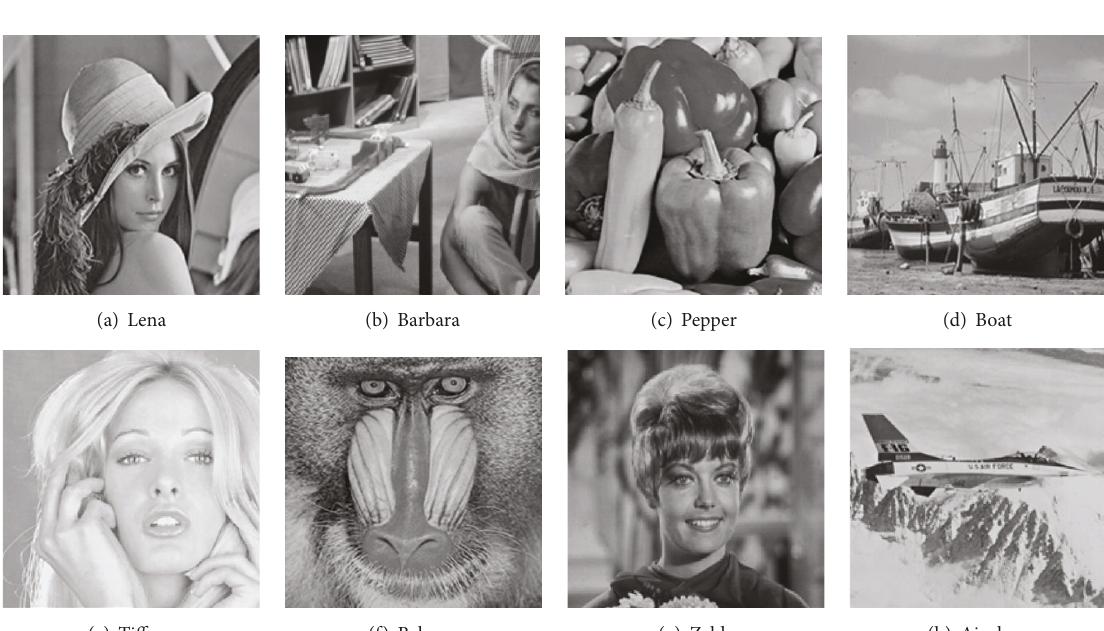
Figure 4: The eight stego images (B=27,